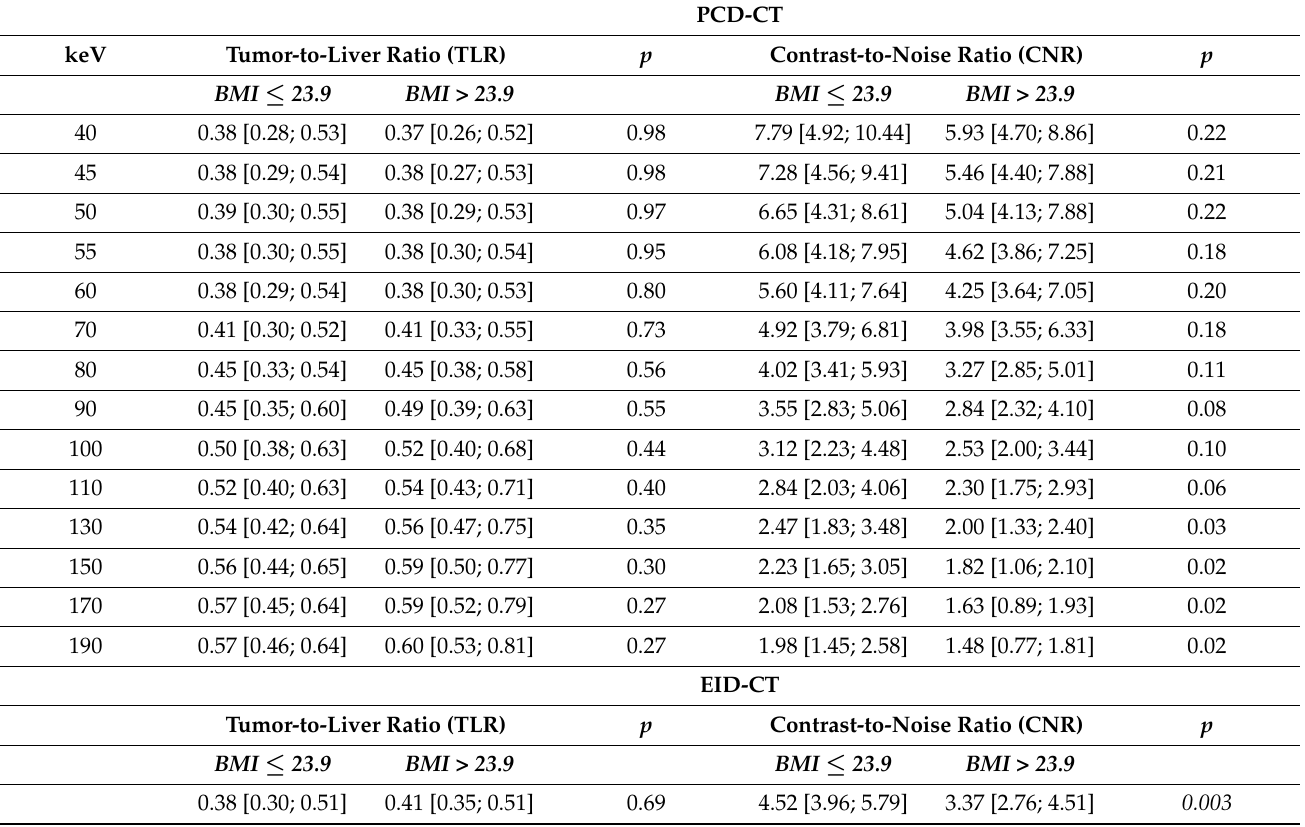
Table 4. Tumor-to-liver ratio and contrast-to-noise ratio at different keV levels for PCD-CT and EID-CT, divided in BMI subgroups by median